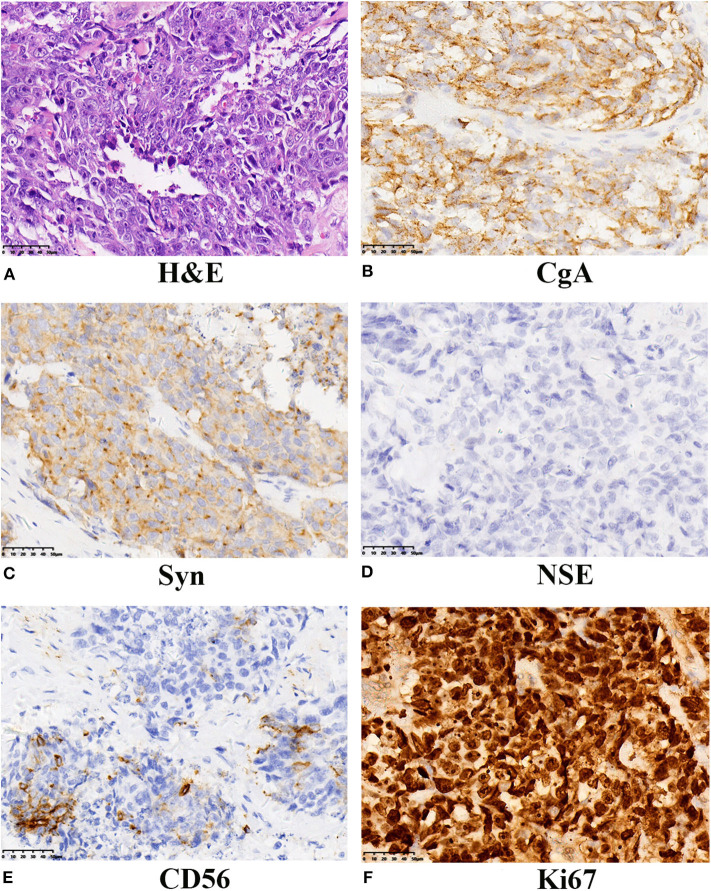
Histochemical and immunohistochemical examinations of the tumor from our case. (A) LCNEC of the bladder showed large cells with large nuclear size, prominent nucleoli, and abundant cytoplasm. (H&E staining, ×400). The neoplasm displayed positive expression of CgA (B), strong and diffused expression of Syn (C), absent NSE expression (D), positive for CD56 (E), and the proliferative index Ki67 was 90% (F). A final diagnosis of LCNEC was performed. LCNEC, large cell neuroendocrine carcinoma; H&E, hematoxylin and eosin; CgA, Chromogranin A; Syn, synaptophysin; NSE, neuron specific enolase.